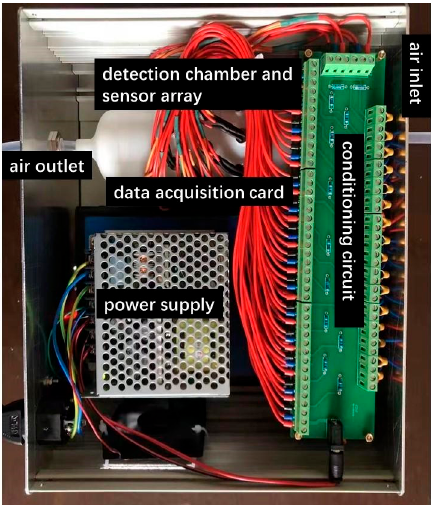
Figure 3. Internal structure view of a self-made electronic nose system.